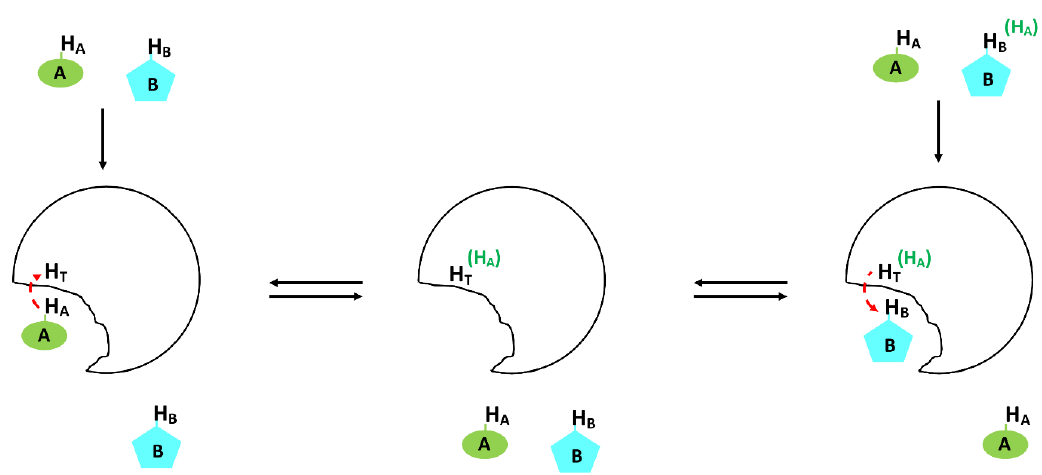
Figure 10. Schematic representation of the principle of the INPHARMA. The inter-ligand NOEs observed between two competitive ligands A (in green) and B (in blue), which bind consecutively to the same target receptor T. The figure is adapted from [284].